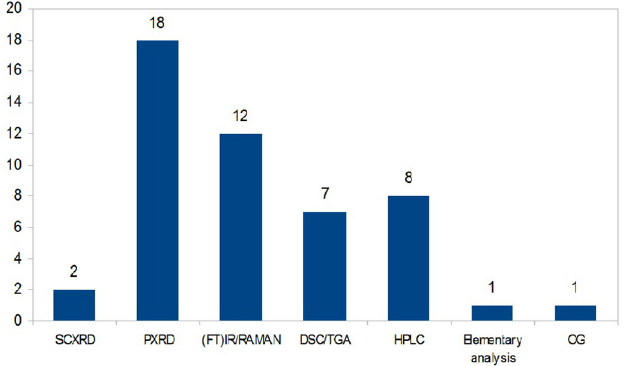
FIGURE 3 – Analytical techniques for characterization of the crystalline phase present in clopidogrel patent